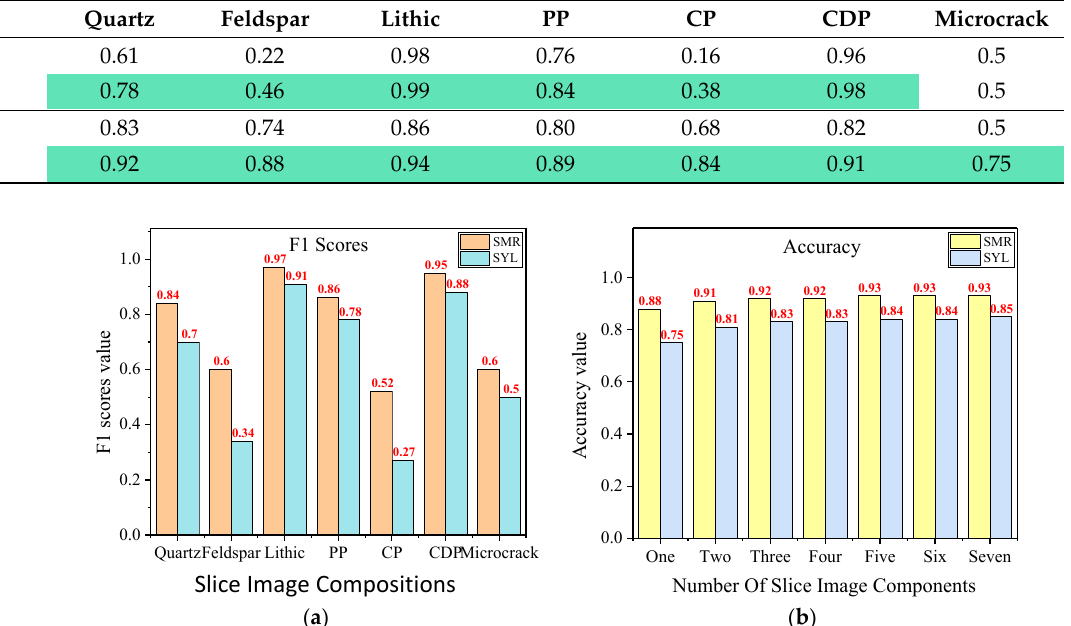
Figure 9. F1 scores for both algorithms and accuracy for different components: ( a ) F1 scores for both algorithms, ( b ) accuracy of different components of two algorithms.